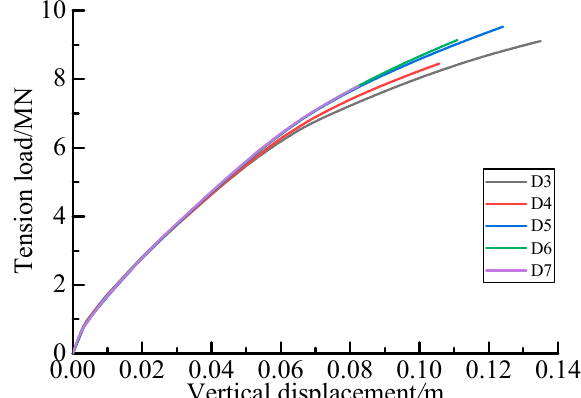
Figure 23. Uplift load-displacement curves of screw piles with various blade diameters. When the displacement is 0.12 m, the uplift load is 8.70 MN and 9.38 MN for D3 and D5, respectively, representing an increase in uplift capacity of 7.82%.